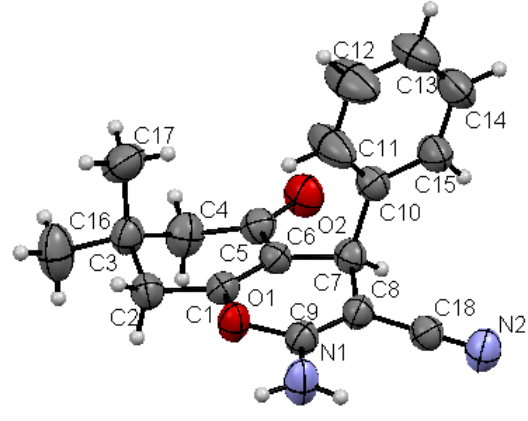
Figure 3. X-ray crystal structure of ( S )-2-amino-7,7-dimethyl-5-oxo-4-phenyl-5,6,7,8- tetrahydro-4 H -chromene-3-carbonitrile( 6d